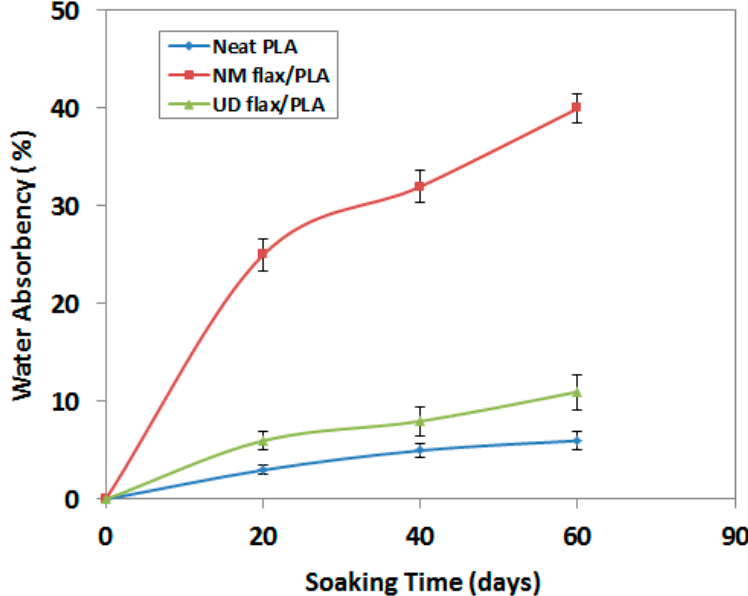
Figure 8. Water absorbency performance of unreinforced and flax reinforced PLA.